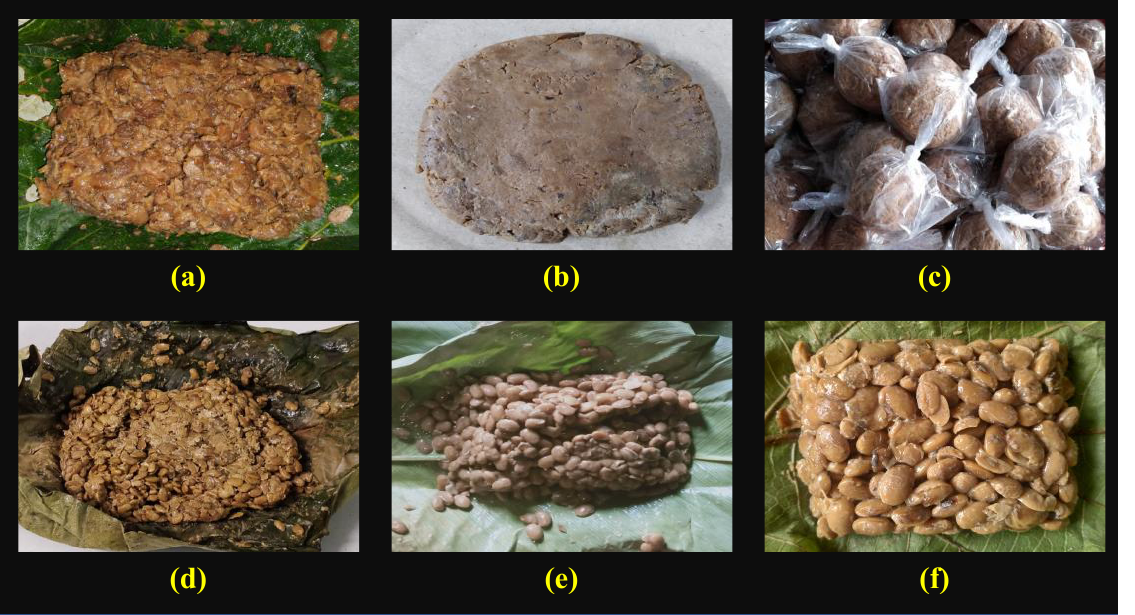
Figure 1. Naturally fermented soybean foods of the Eastern Himalayas ( a ) kinema , ( b ) grepchhurpi , ( c ) peha , ( d ) peron naming , ( e ) perunyaan and ( f ) bemerthu .